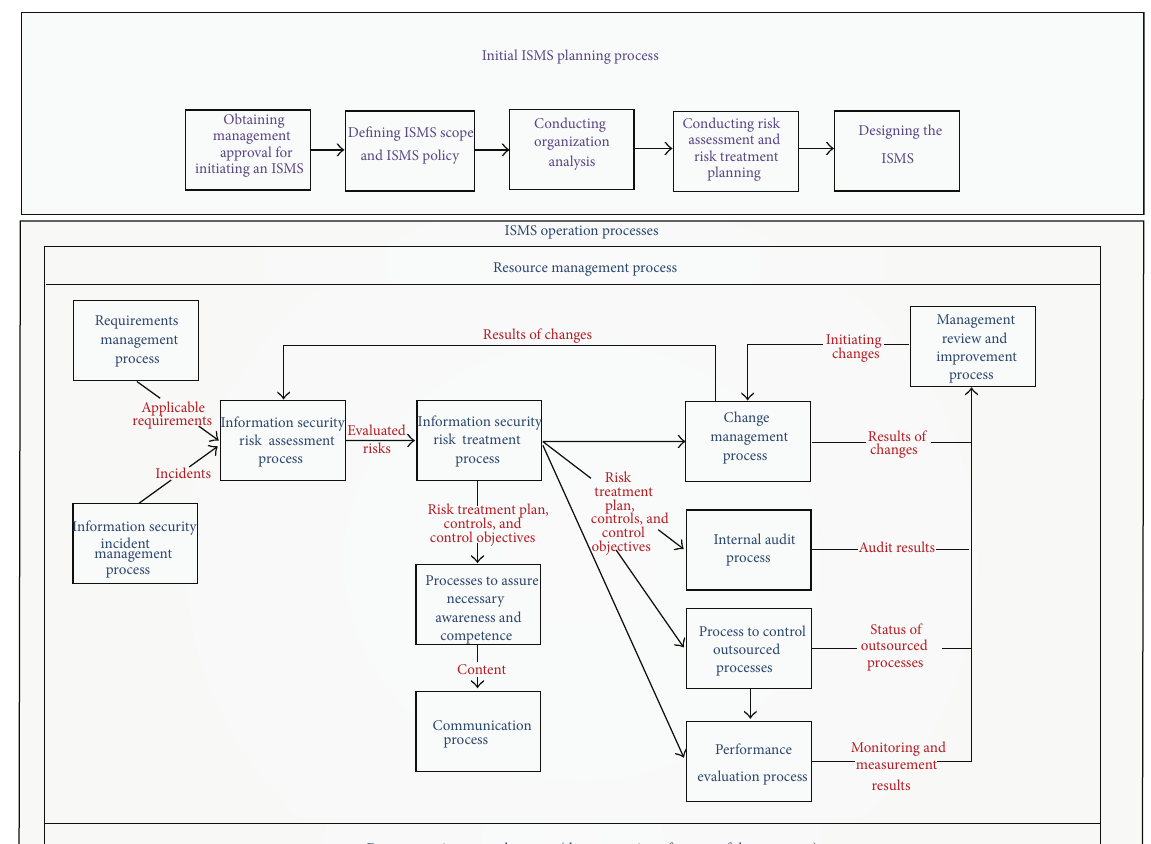
Figure 1: ISMS process